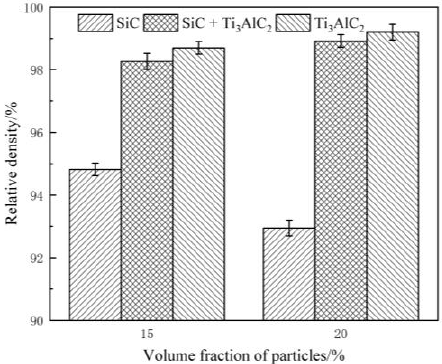
Figure 7. The relative densities of the as-prepared samples.